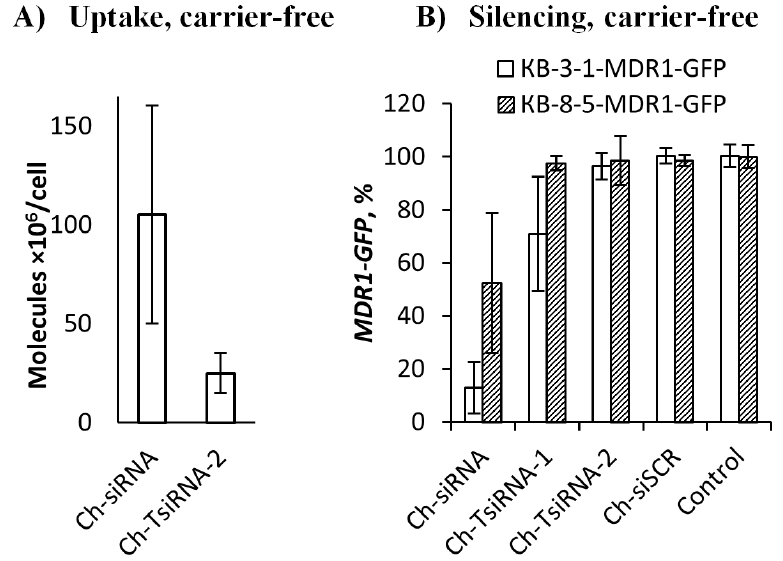
Figure 1. Accumulation ( A ) and silencing activity ( B ) of cholesterol-modified siRNAs and TsiRNAs in a carrier-free mode in vitro. ( A ) Accumulation of monomer (Ch-siRNA) and trimeric (Ch-TsiRNA-2) cholesterol-modified siRNAs in KB-8-5 cells 4 h after addition (1 µM), measured by stem-loop RT-PCR. B) Silencing activity of Ch-siRNA, Ch-TsiRNA-1 and Ch-TsiRNA-2 three days after addition (5 µM) to KB-8-5-MDR1-GFP or KB-3-1-MDR1-GFP cells, fluorescence intensity value of untreated cells was used as a 100%.